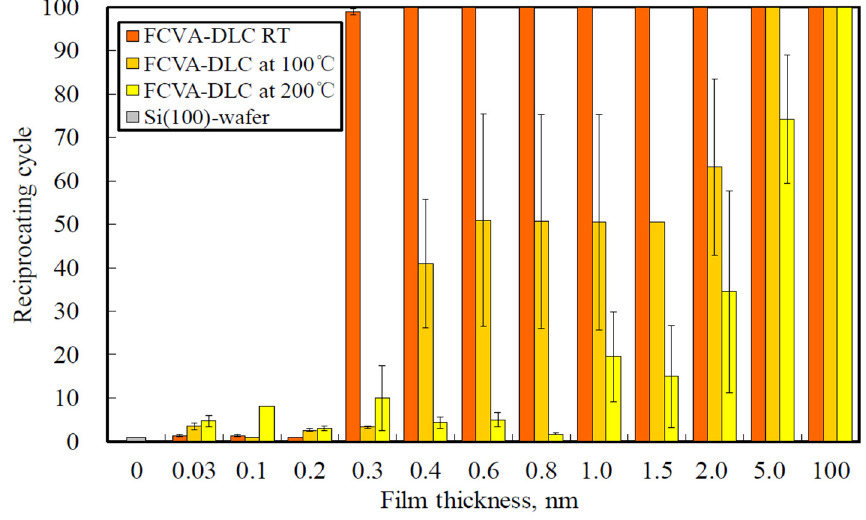
Figure 9. Endurance reciprocating cycle of FCVA-DLC films at various temperatures.